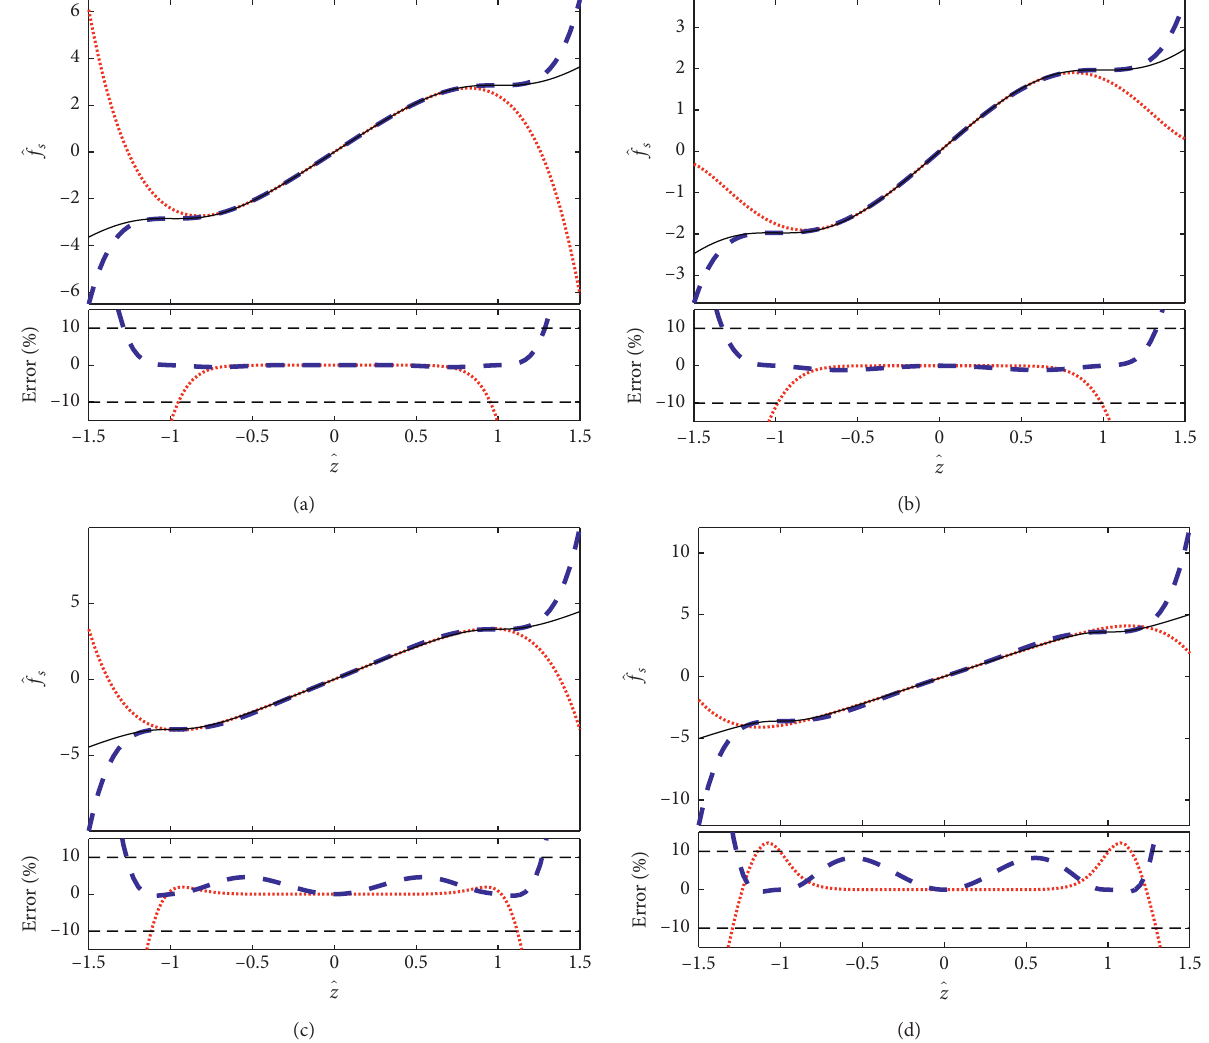
Figure 7: Force-displacement curve corresponding to different combinations of the system parameters as indicated by the (a) circle, (b) square, (c) diamond, and (d) star in Figures 5 and 6. Exact curves from equation (7) are represented as solid lines; Taylor series ap- proximations are represented as dotted lines; and polynomial approximations using equation (8) are represented as dashed